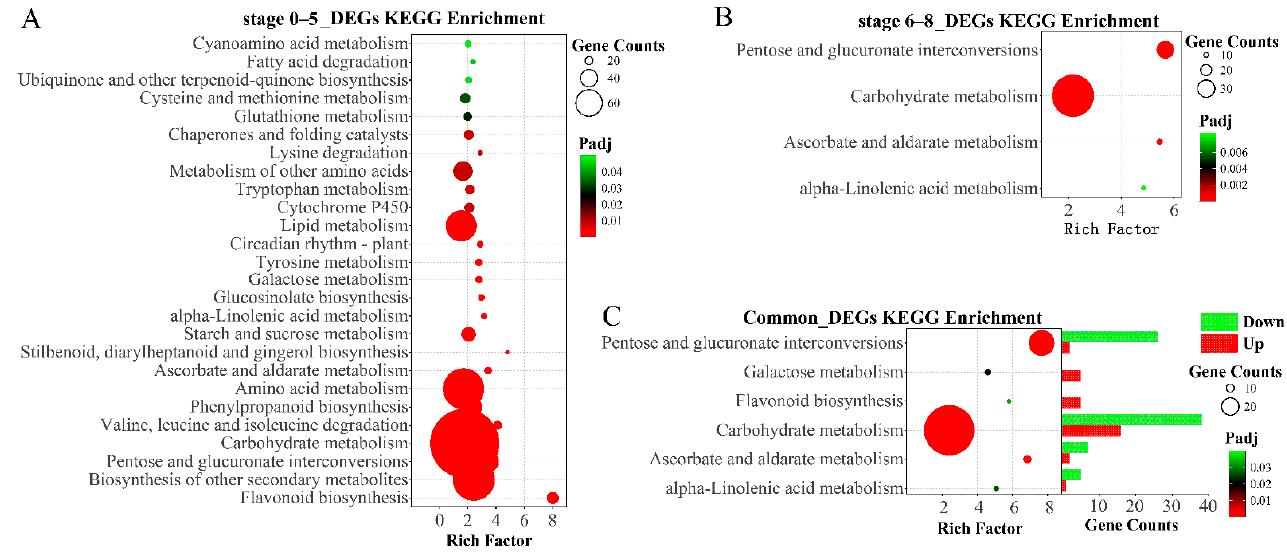
Figure 3. KEGG pathway significant enrichment analysis of DEGs at stage 0–5 ( A ), 6–8 ( B ), and both periods ( C ). periods ( C